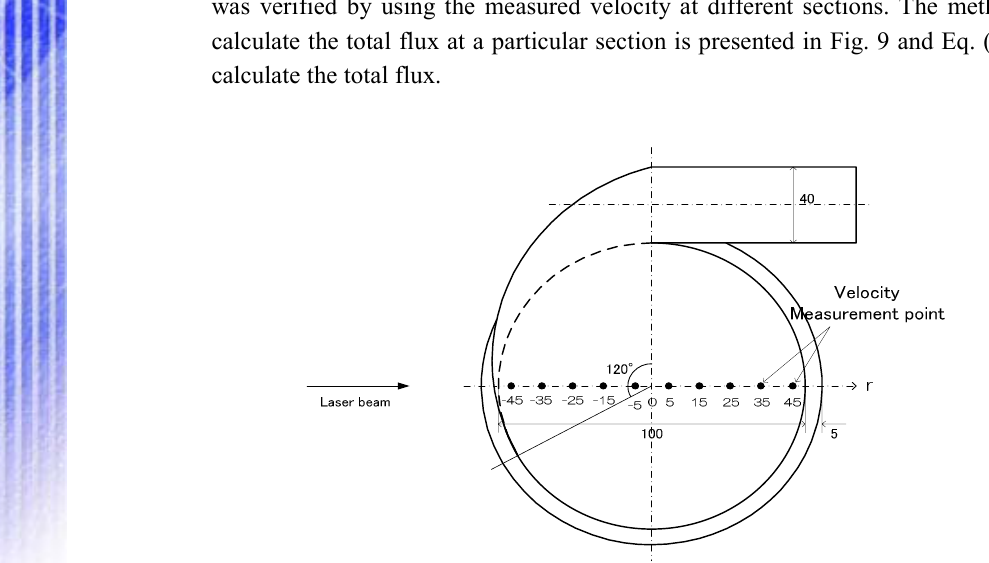
Fig. 7: 0-degree position of reactor cylinder for X and Y-velocity component